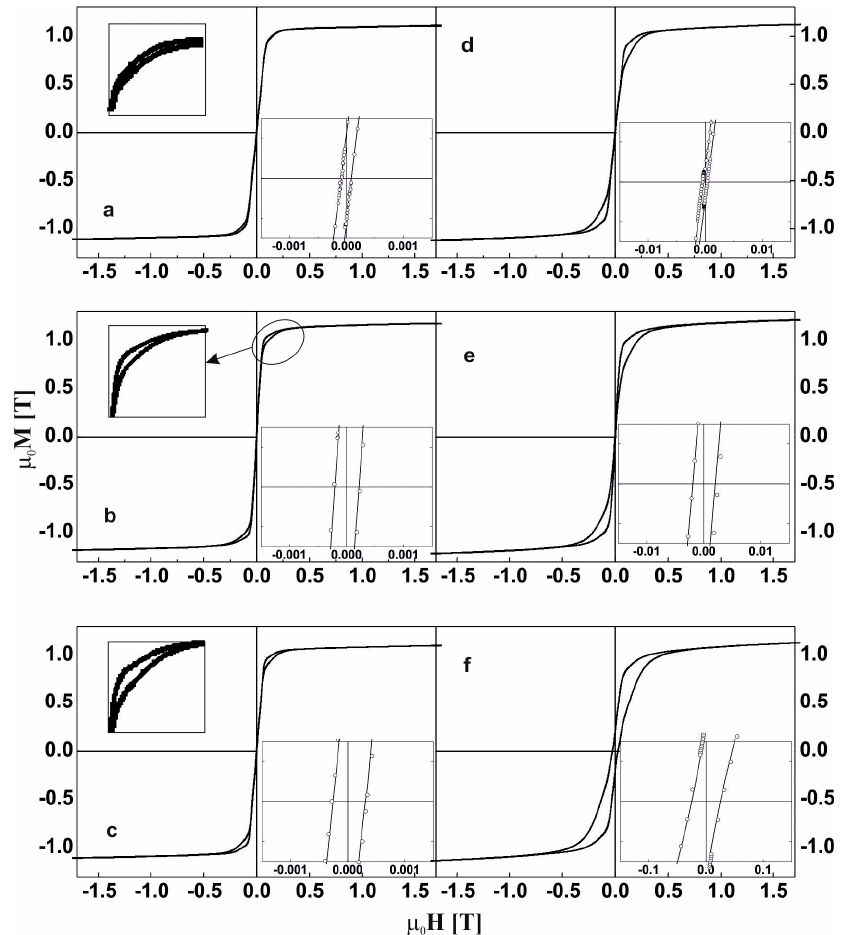
Figure 8. The static magnetic hysteresis loops for the alloys in the as-cast state ( a – c ) and after the thermal treatment at 940 K for 10 min ( d – f ) made by the suction-casting method: Fe 61 Co 10 W 1 Y 8 B 20 , ( a , d ), Fe 62 Co 9 W 1 Y 8 B 20 ,( b , e ), Fe 63 Co 8 W 1 Y 8 B 20 ( c , f ).